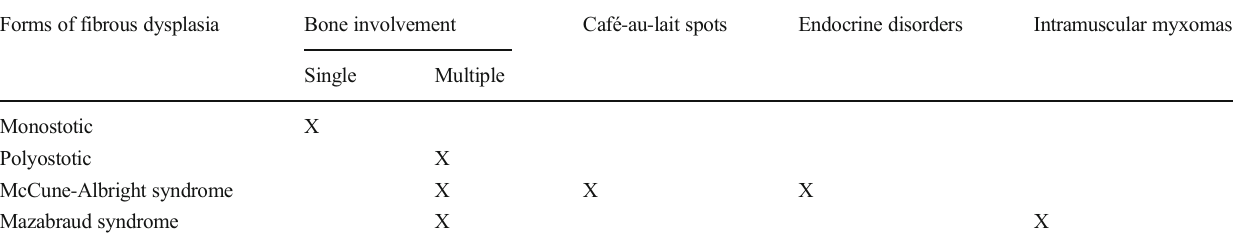
Nomenclature of the diseases associated with fibrous dysplasia (FD) lesions Forms of fibrous dysplasia Bone